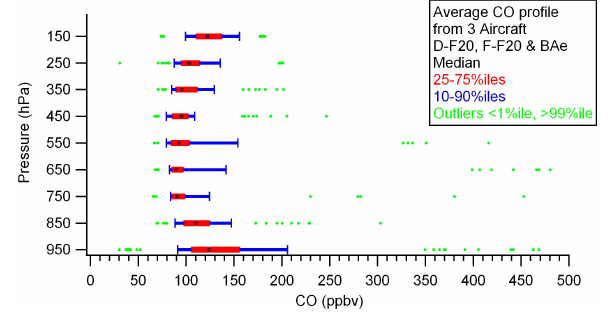
Fig. 5. Average vertical profile of CO concentrations in bins of 100hPa of atmospheric pressure based on 1-min data from the BAe- 146, the DLR Falcon and the French Falcon between 20 July and 21 August. The black marker is the median, the red box the range of the 25 to 75 percentiles, the blue whiskers the range of the 10 to 90 percentiles and the green points outliers less than the 1 percentile and greater than the 99 percentile. Note that the concentrations have been scaled according to the comparisons of standards.